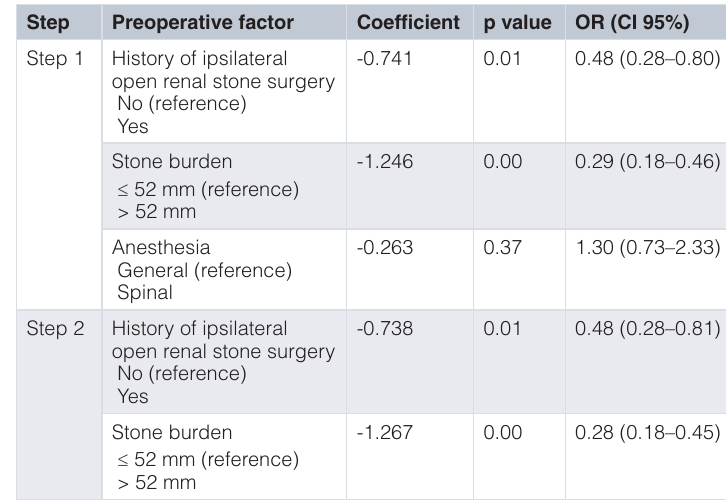
Table 3. Multivariate analysis (logistic regression model) of factors independently predictive of stone-free